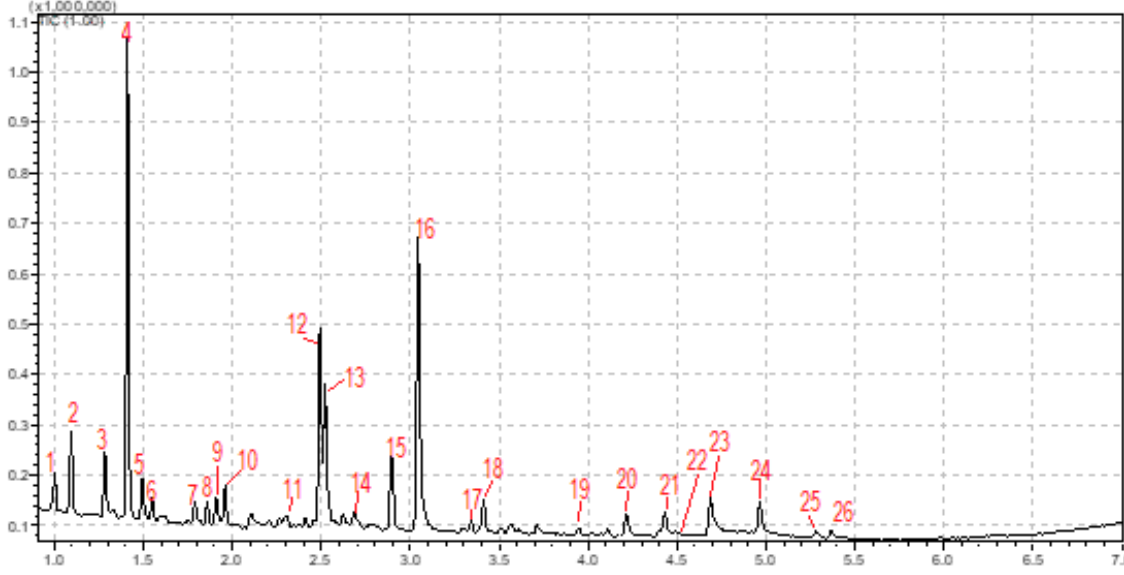
Figure 4. Amaranth seed amino-acid profile: 1 = alanine, 2 = glycine, 3 = valine, 4 = internal standard, 5 = leucine, 6 = isoleucine, 7 = threonine, 8 = serine, 9 = proline, 10 = asparagine, 11 = thioproline, 12 = aspartic acid, 13 = methionine, 14 = 3-hydroxyproline, 15 = phenylalanine, 16 = glutamic acid, 17 = α -aminopimelic acid, 18 = glutamine, 19 = 4-hydroxylserine, 20 = hydroxyproline dipeptide, 21 = histidine, 22 = lysine, 23 = tyrosine, 24 = tryptophan, 25 = cystationine, and 26 =